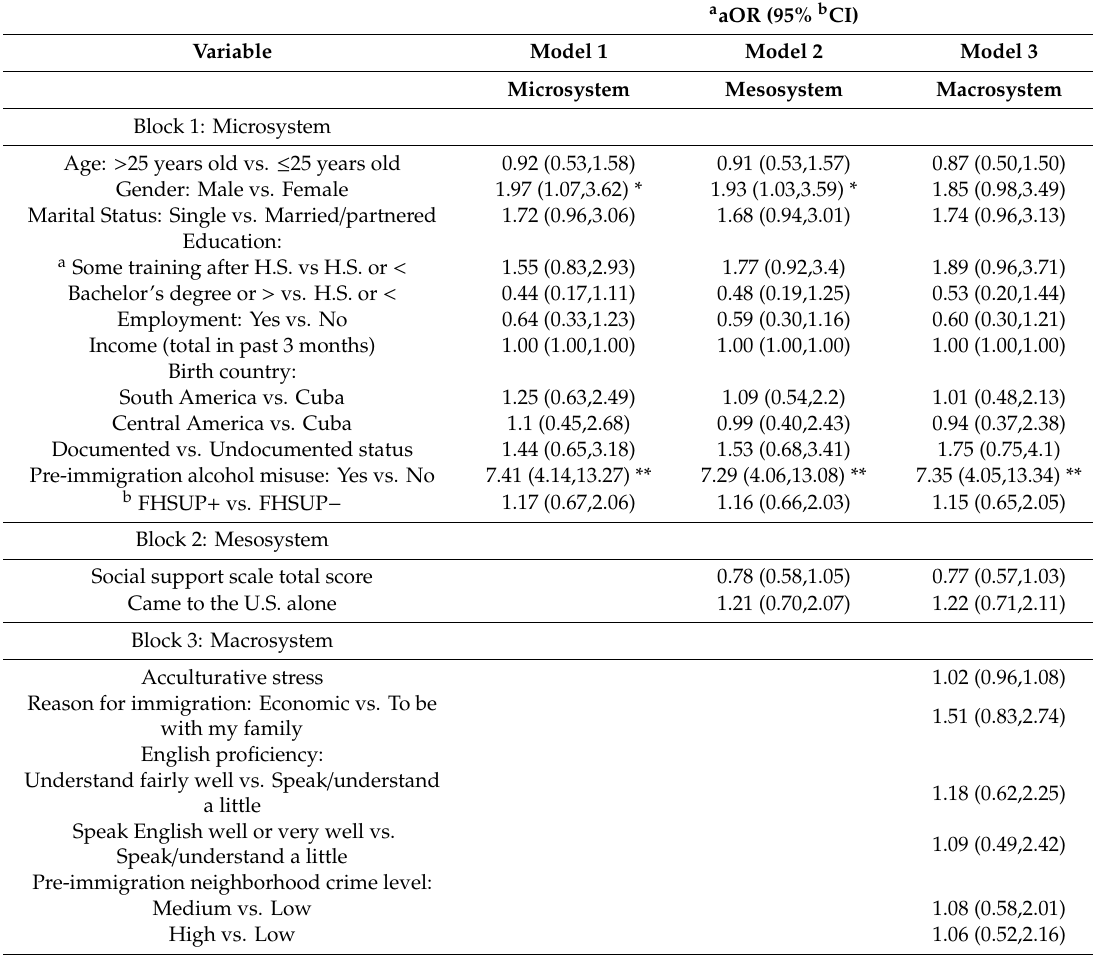
Table 4. Hierarchical multiple logistic regression model for predicting alcohol misuse (N =